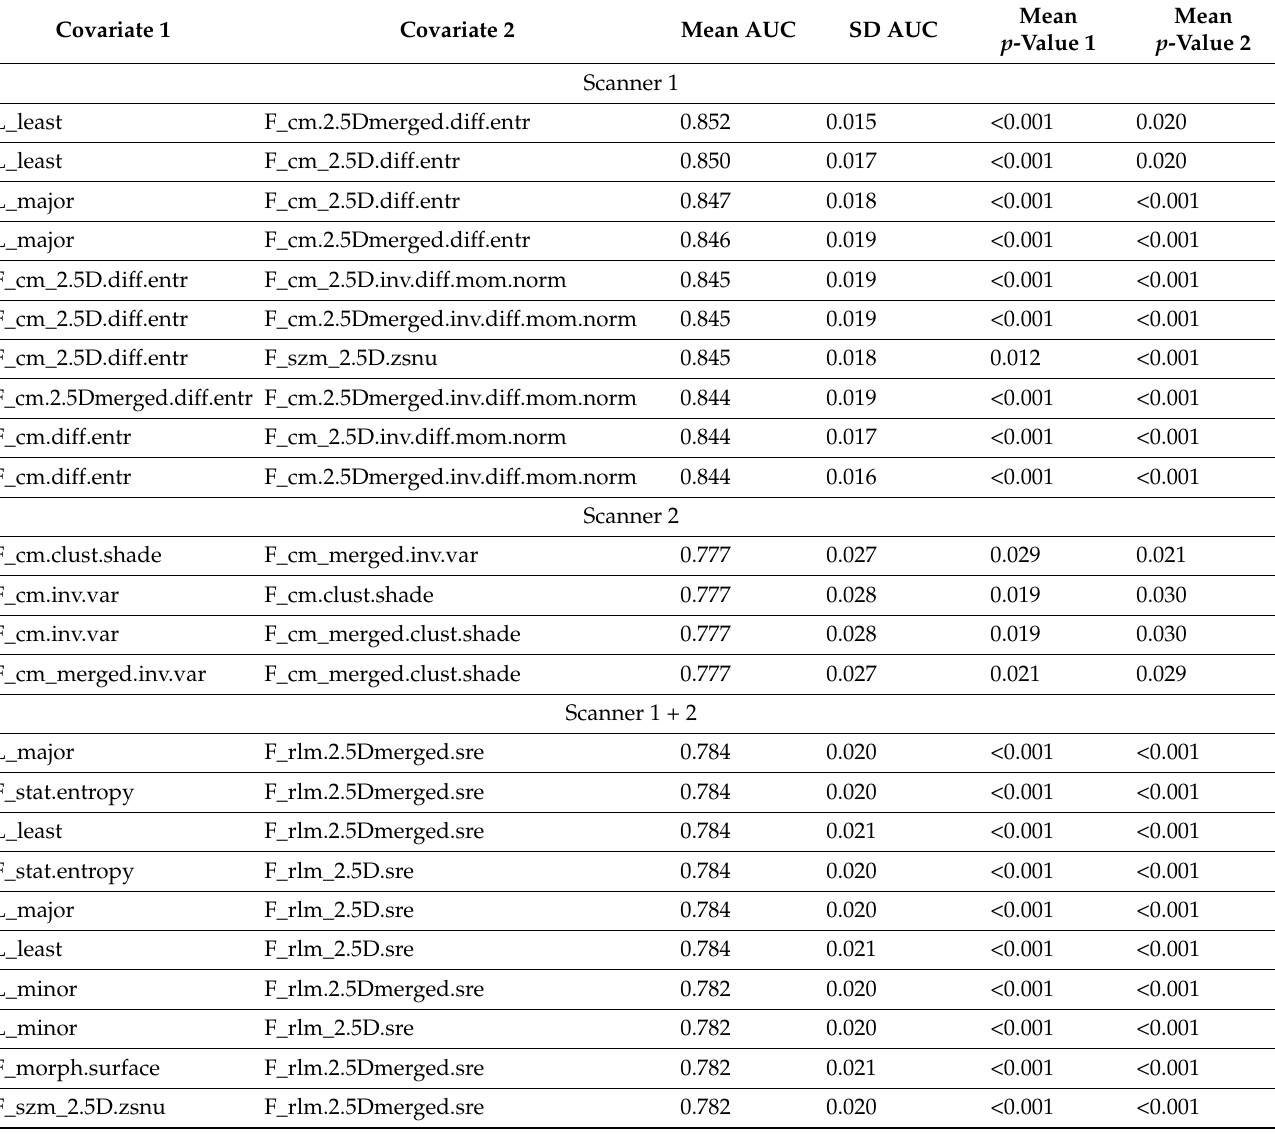
Table 2. Couples of RaF with best performances at logistic regression analysis for scanner 1, scanner 2 and both scanners